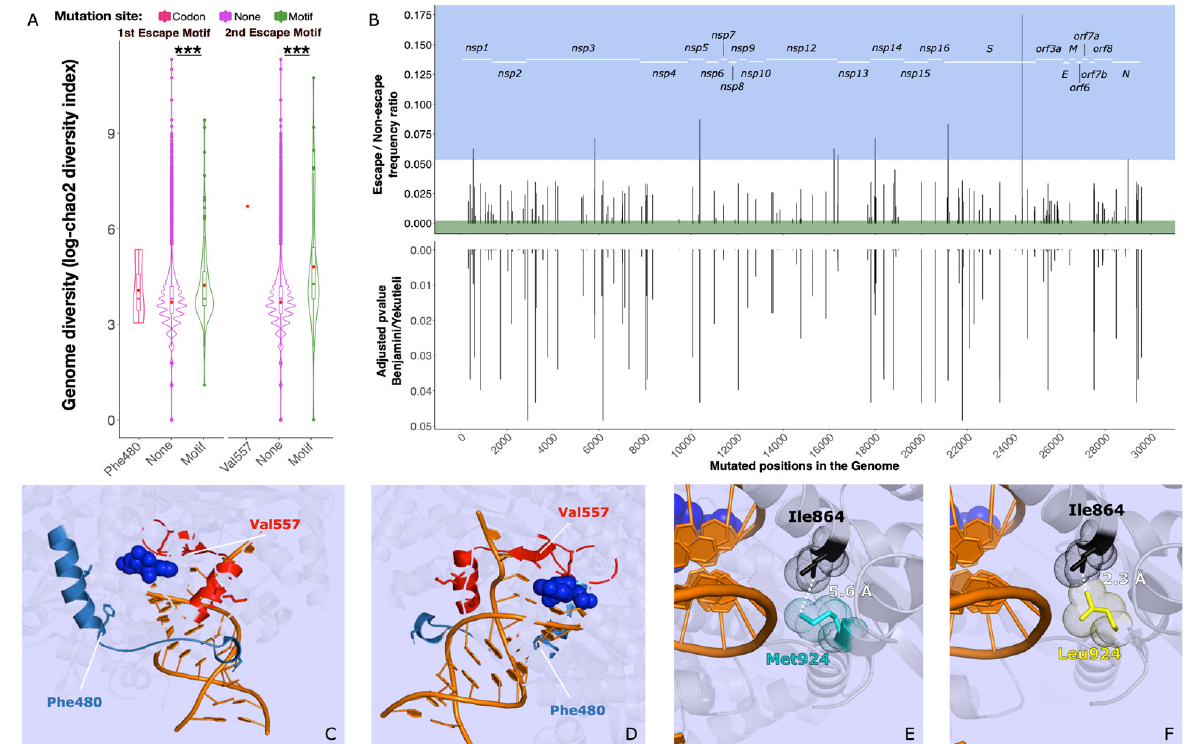
Figure 3. Mutations in escape motifs harbour higher genome nucleotide and tightly associated mutations: The genome entropy is significantly higher in 1st and 2nd motif escape mutants. ( A ) Diversity is calculated as incidence-based mutation richness along the chao2 diversity index, boxplot represents the interquartile range, red dots indicate the mean. Stars indicate the merged p-value with *** indicating a p -value < 0.001. Significance was calculated with a Monte Carlo t-test simulation, see methods. ( B ) Association between escape mutants and other mutations across the genome. Candidates are evaluated through generalised linear models fit with lineage correction. Upper panel: depiction of mutation incidence ratio escape/non escape. Only mutations showing a ratio > 95th percentile are considered escape-associated (light blue area), of note mutation in position 16,210 is significantly associated to escape mutants. Lower Panel: adjusted p-value for multiple testing according to Benjamini-Yekutieli—only mutations with significant pvalues are shown. ( C , D ) Location of escape mutations on RdRp bound to RNA template (in orange) and remdesivir (in electric blue), 1st escape motif is indicated in blue, 2nd escape motif is indicated in red. ( E , F ) Met924Leu (encoded by a SNP in position 16,210) decreases the distance to Ile864 by more than 2-fold. Panel ( E ) depicts the original residue Met924 (in cyan) while panel ( F ) depicts the in silico mutated residue Leu924 (in yellow) Cartoons and atomic structures are generated through the Pymol software on the protein crystal structure PDB ID: 7BV2 [44].